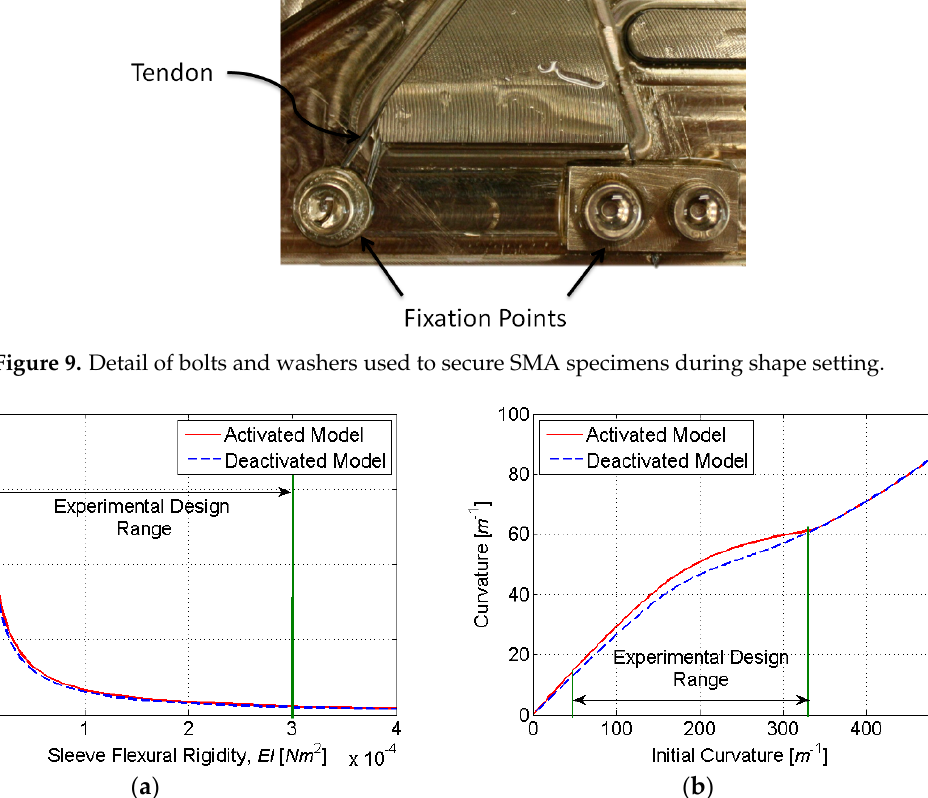
Figure 10. Simulation results used to determine the parametric range of ( a ) EI and ( b )